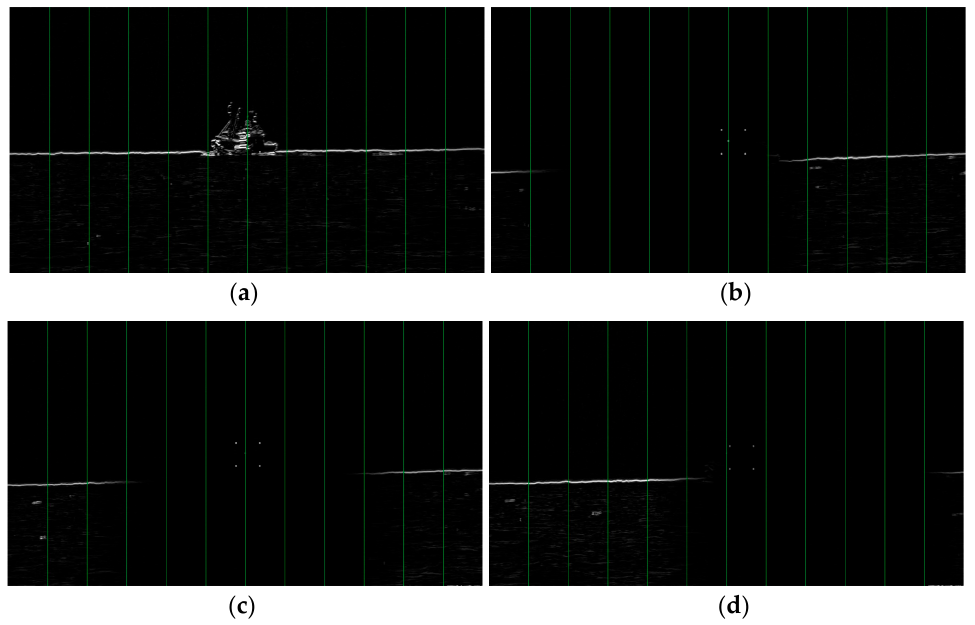
Figure 9. Schematic diagram of the image segmentation: ( a ) A scene before the object is obscured; ( b ) The scene 1 where the object is obscured; ( c ) The scene 2 where the object is obscured; ( d ) The scene 3 where the object is obscured.